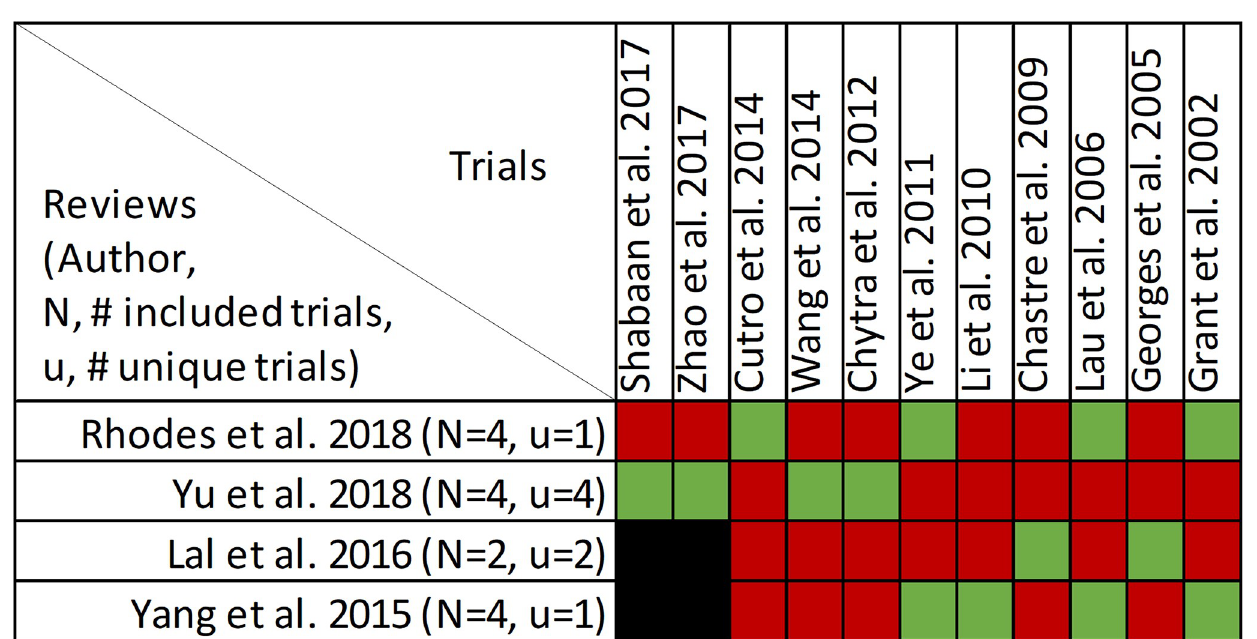
Fig 9. Citation matrix for reviews reporting microbiologic cure of prolonged infusions. Green—primary studies included in systematic review, Red— primary study not included in systematic review, Black—primary studies published after systematic review and therefore ineligible for possible inclusion.